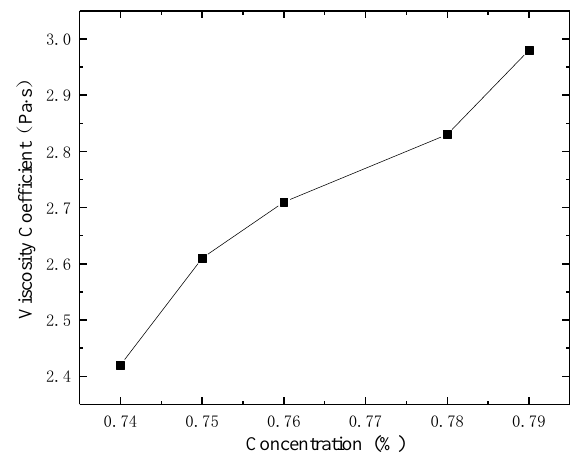
Figure 8. Relation between viscosity coefficient and slurry mass concentrations.